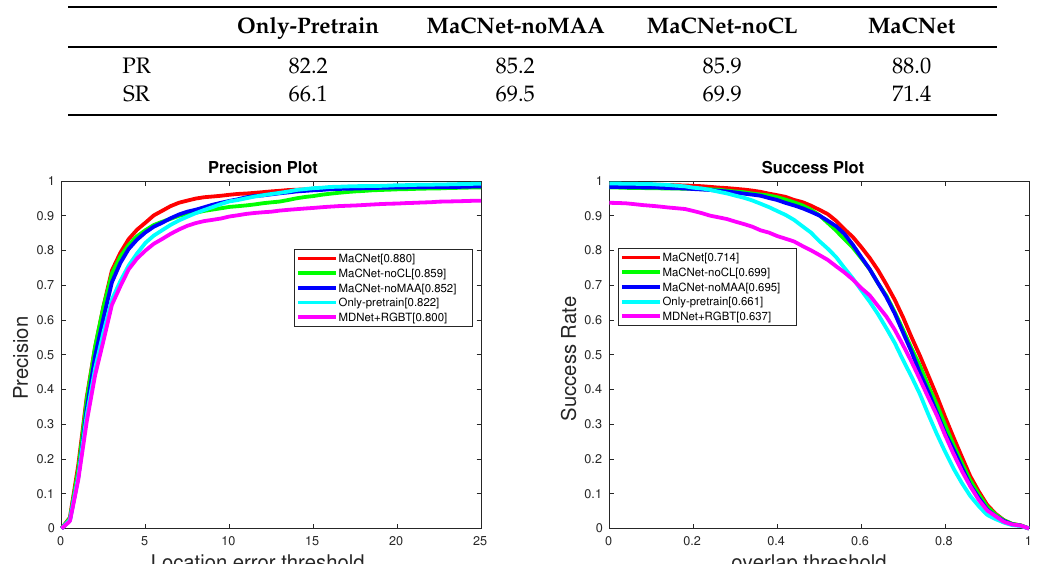
Table 7. PR/SR scores (%) of different variants induced from modal-aware attention network and competitive learning (MaCNet) on the GTOT dataset [12].